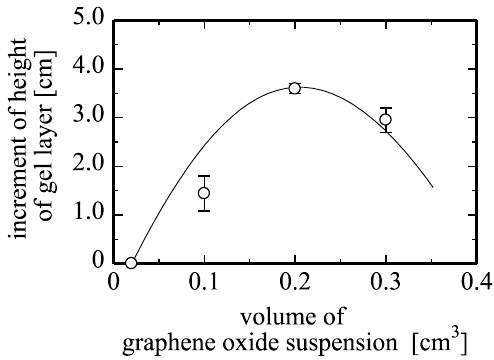
Figure 4. Height of gel layer vs. volume of graphene oxide suspension. Initial height of gels: 0.7 cm, conc. of graphene oxide: 1.0 g · L − 1 ; the flow rate of water: 1000 mL · h − 1